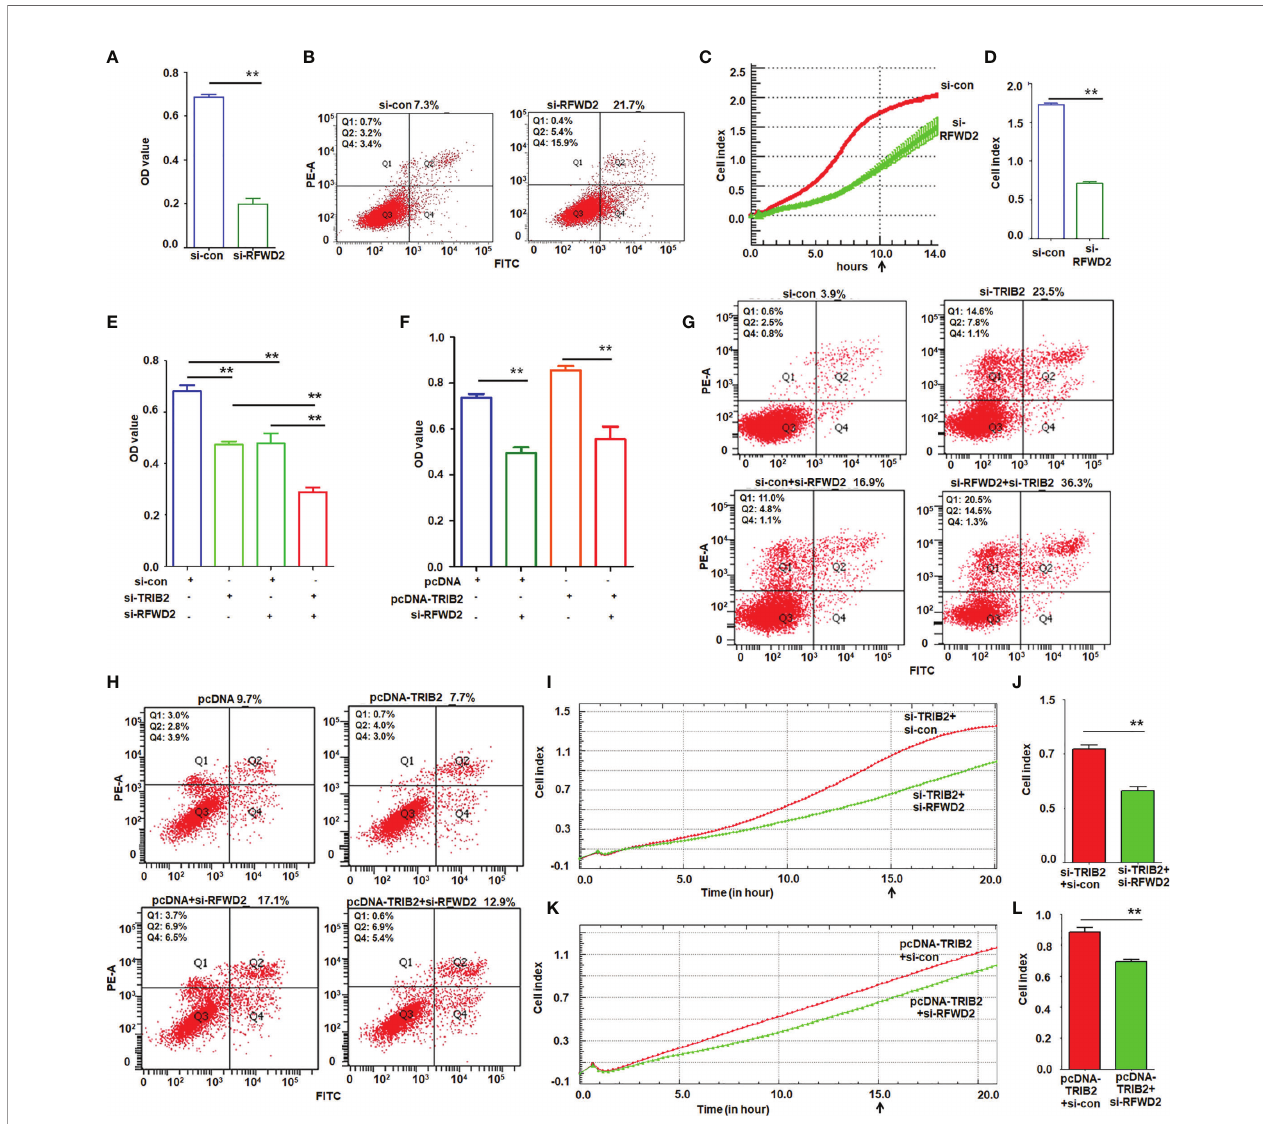
FIGURE 6 | TRIB2 promotion of cell growth and migration depends on RFWD2. (A) MTT assay showing that RFWD2 downregulation inhibited A549 cell proliferation. Data were expressed as the mean ± SD from triplicate experiments. ** p < 0.01; Student ’ s t -test. (B) Apoptotic rate of A549 cells transfected with RFWD2-siRNA for 48 h measured via fl ow cytometry from triplicate experiments. (C, D) RFWD2 knockdown inhibited cell migration. A549 cells treated with siRNAs were analyzed via a real- time migration assay on an xCELLigence RTCS. Data are expressed as the mean ± SD of triplicate experiments. ** p < 0.01; Student ’ s t -test. (E) Viability of A549 cells transfected with the indicated siRNAs analyzed via MTT assay. Data are expressed as the mean ± SD of triplicate experiments. ** p < 0.01; ANOVA. (F) Cell viability of A549 cells following treatment with the indicated plasmids or siRNAs, as analyzed by MTT assay. Data are expressed as the mean ± SD of triplicate experiments. ** p < 0.01; ANOVA. (G) TRIB2 and RFWD2 downregulation promotes apoptosis, as shown by fl ow cytometry assay performed in triplicate. (H) Cell apoptosis induced by RFWD2 knockdown is rescued by TRIB2 overexpression as evaluated in triplicate. (I, J) Real-time migration assay on an xCELLigence RTCS showed that simultaneous knockdown of RFWD2 and TRIB2 inhibited migration more strongly than TRIB2 knockdown alone. Cell index represents the mean ± SD of triplicate experiments. ** p < 0.01; Student ’ s t -test. (K, L) Real-time migration assay on an xCELLigence RTCS showed that TRIB2 overexpression recused migration inhibition caused by RFWD2 knockdown. Cell index represents the mean ± SD of triplicate experiments. ** p < 0.01; Student ’ s t